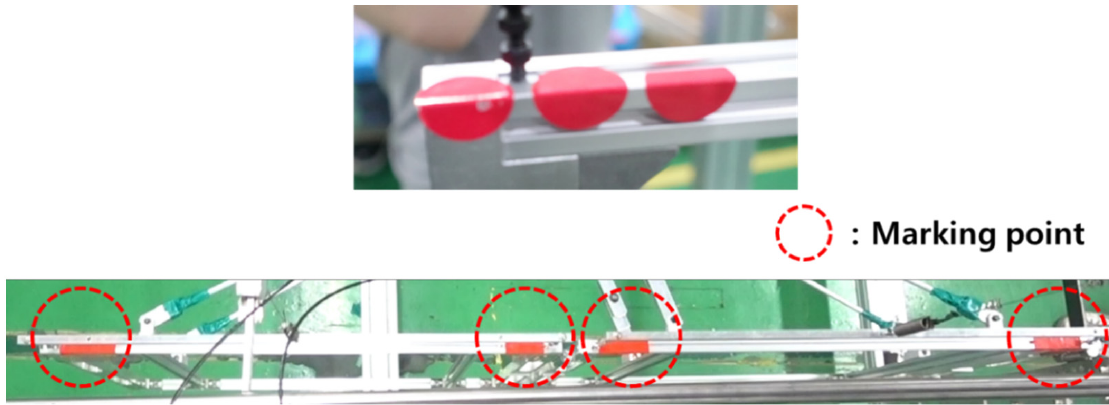
Figure 8. Configuration of red markers on dummy panels.